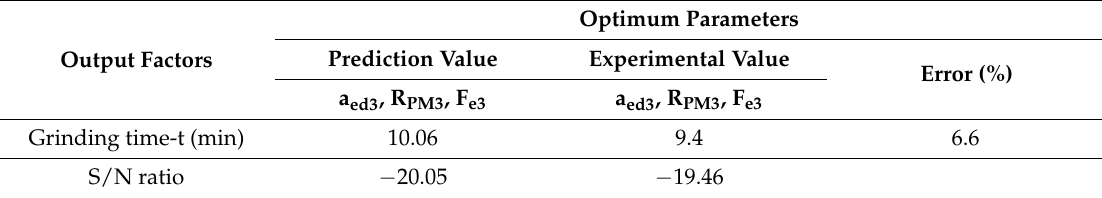
Table 8. Comparison results between calculation value and experimental